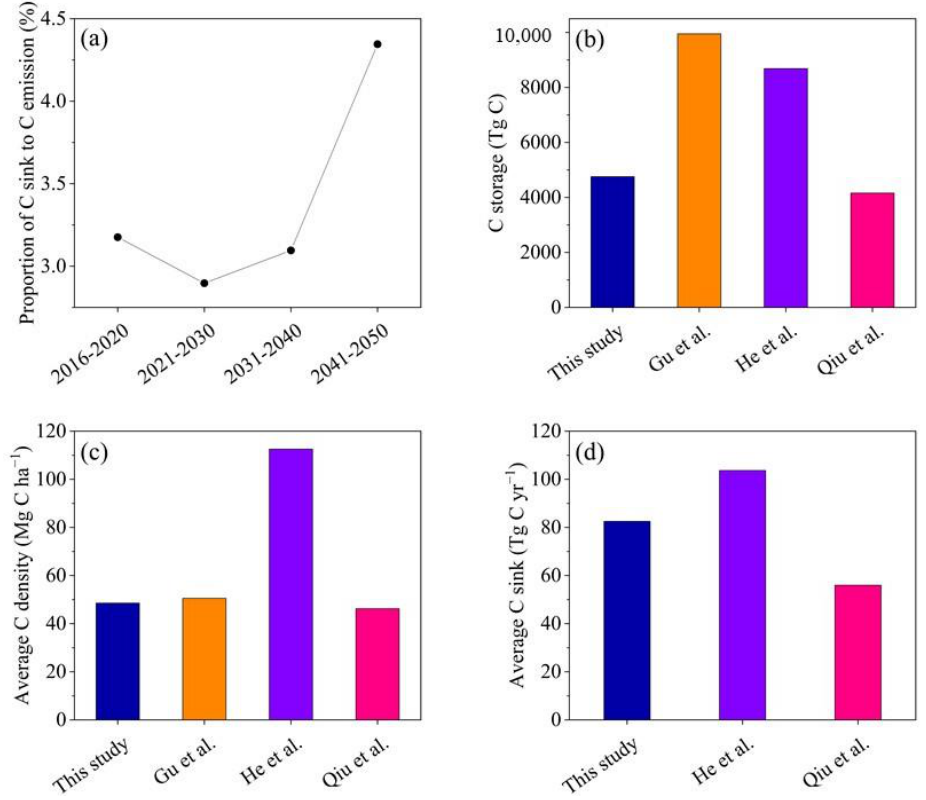
Figure 7. Forest C sink potential and its comparison with previous results. ( a ) shows the propor- tion of forest biomass C sink in the YREB to CO 2 emission in China from 2016 to 2050; ( b ) shows the comparison of this study with Gu et al.[22], He et al. [9] and Qiu et al. [12] on forest C